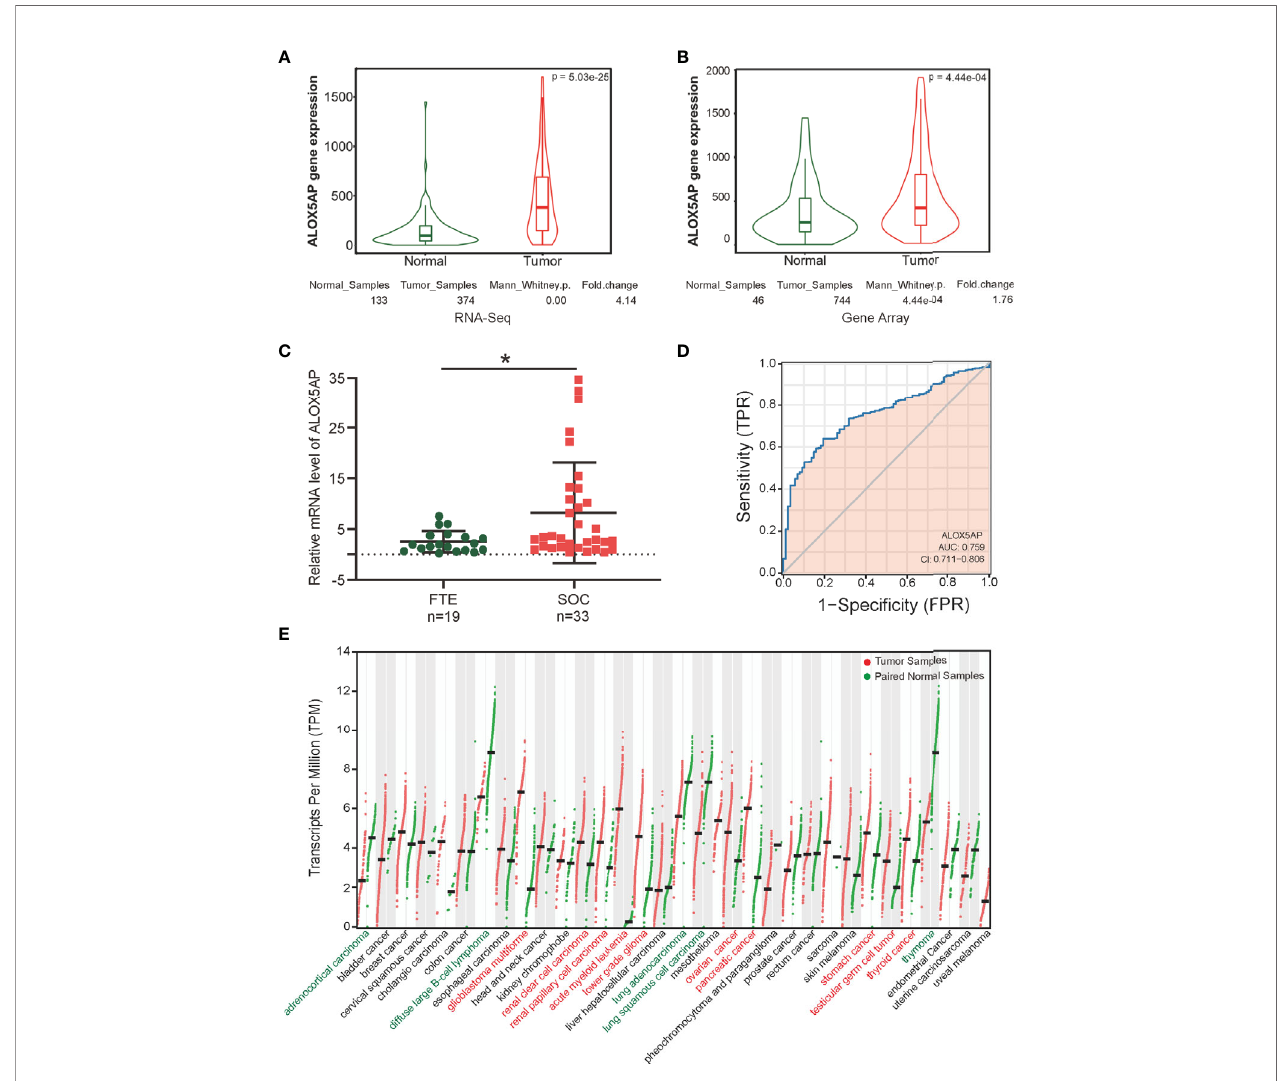
FIGURE 1 | ALOX5AP expression in normal and cancer tissues. Comparison of ALOX5AP expression in SOC and normal controls based on (A) RNA-Seq analysis using TCGA-OV samples and matched normal control samples from the GTEx project, (B) microarray analysis using meta GEO ovarian cancer datasets, and (C) qRT-PCR analysis using clinical SOC and normal control samples from Qilu Hospital of Shandong University. (D) ROC analysis of ALOX5AP expression for the discrimination between SOC and normal controls using TCGA-OV samples and matched normal control samples from the GTEx project. (E) Comparison of ALOX5AP mRNA levels across 33 TCGA cancer types and matched normal controls using GEPIA. (*p <